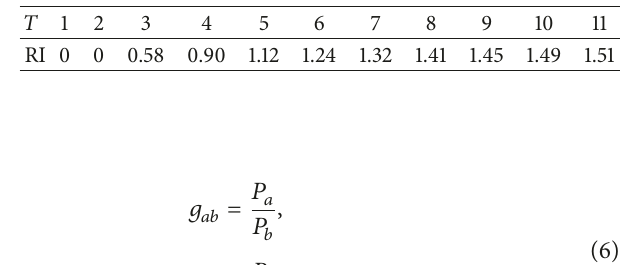
Table 4: The values for average random consistency index